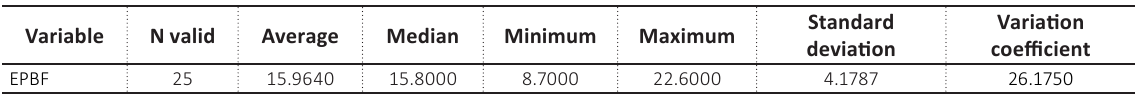
Table 3. Descriptive statistics on the indicator “employed persons by the flexibility to decide on working time by a country”